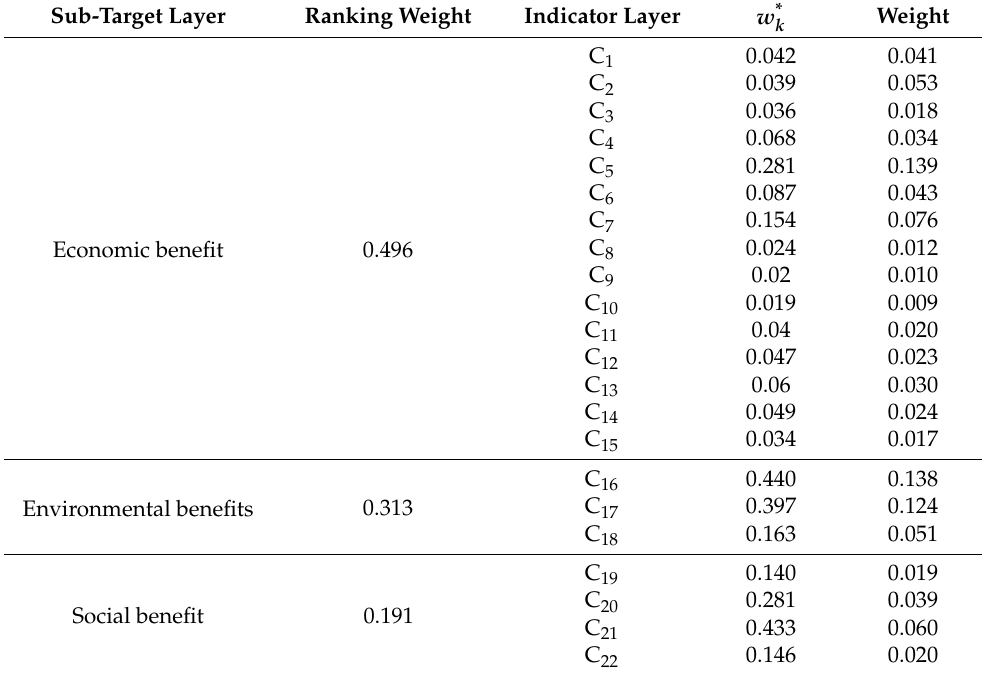
Table 4. Order relation method weight.